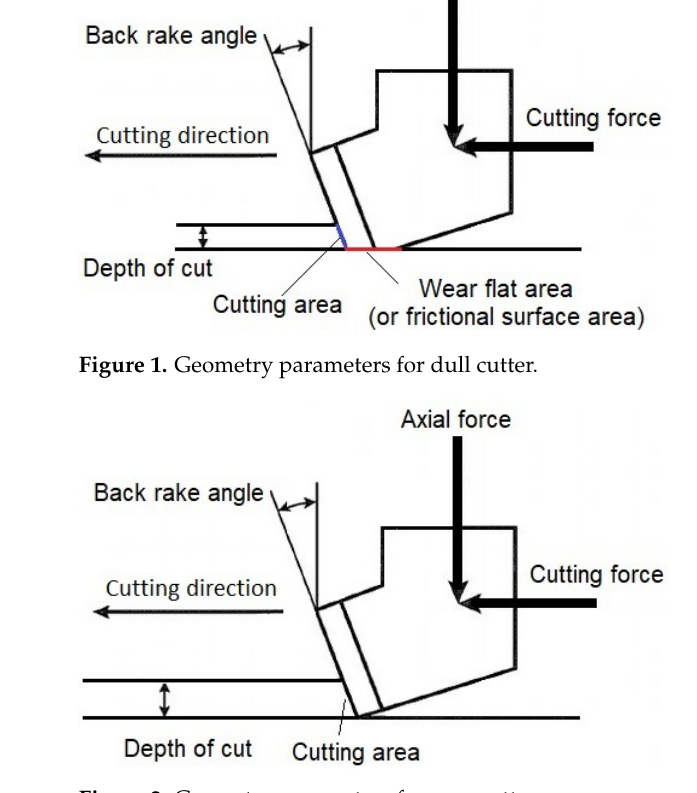
Figure 2. Geometry parameters for new